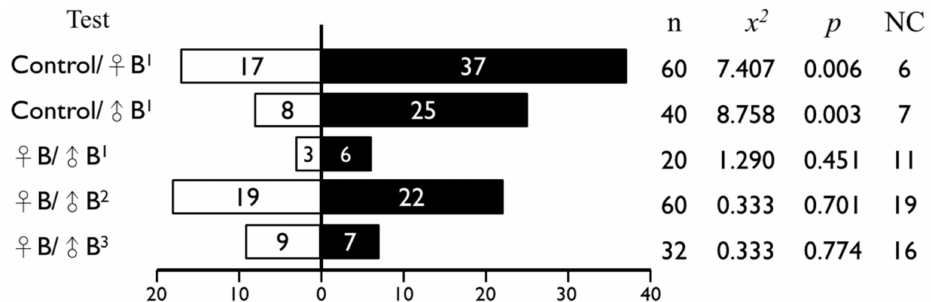
Figure 4. Number of female Ceratosolen responding to fig volatiles in Y-tube olfactometer. The superscript indicates the date of the tests: 1 16.08.2010, 2 26.05.2011 and 3 20.08.2015. NC is “no